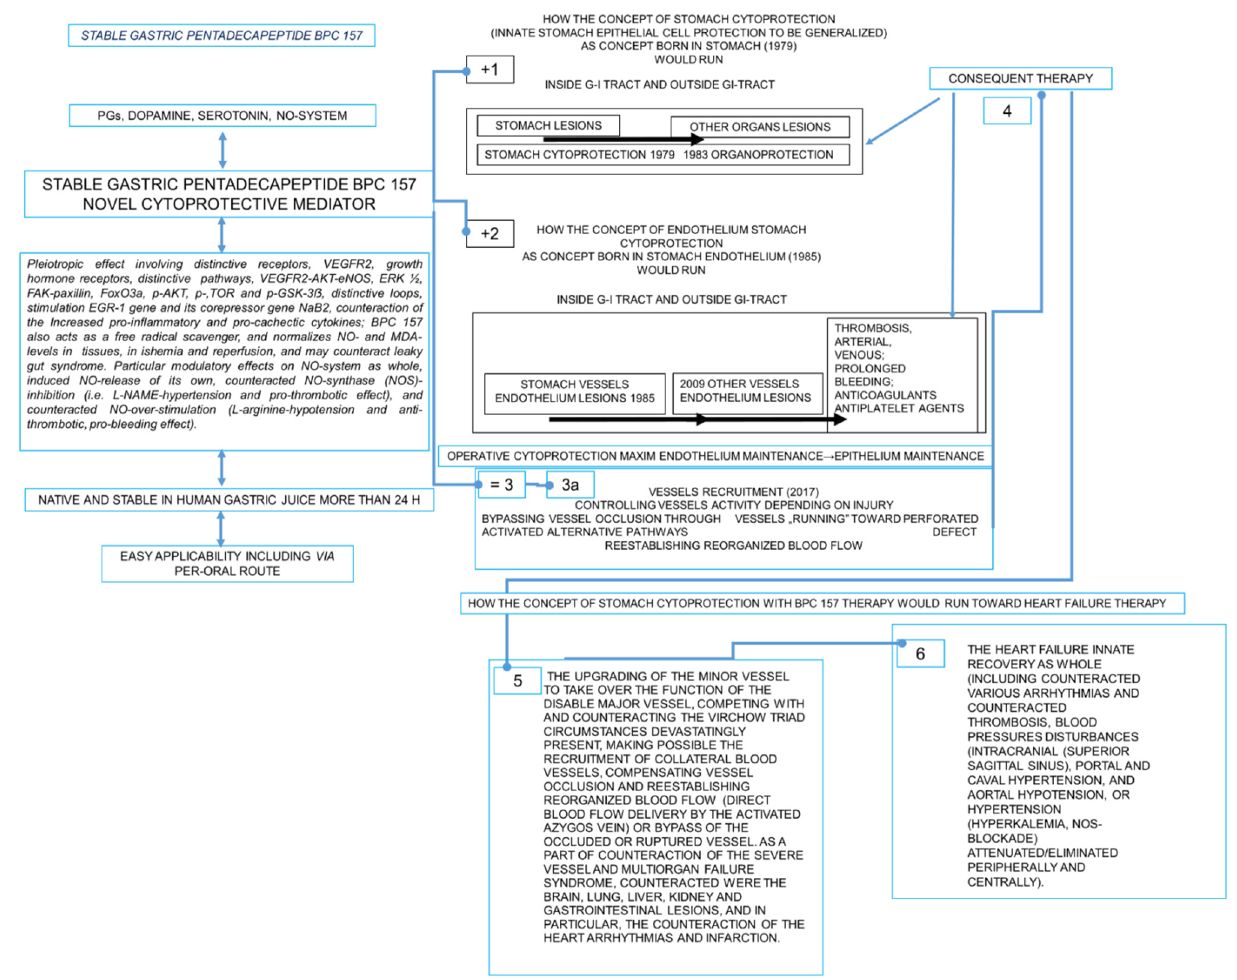
Figure 1. Description of the BPC 157 therapy. Cytoprotection concept (for review, see [2–8,10–17]) born in the stomach appears with cytoprotective agents application as innate stomach epithelial cell protection (indicated as +1) to be generalized (Robert, Szabo) in other organs epithelia protection (organoprotection) supplemented by stomach endothelium cell protection (indicated as +2) (Szabo). Together (+1, +2), these result in cytoprotection stomach maxim endothelial maintenance → epithelial maintenance (indicated as = 3) as axis for the rapid defensive response to resolve the ongoing lesions, which is, however, not fully operative with the standard cytoprotective agents. As novel cytoprotection mediator, BPC 157 might exert prominent epithelial beneficial effects in the stomach and in the whole gastrointestinal tract and in the other organs (stomach cytoprotection → organoprotection) (+1) and endothelial beneficial effect in the stomach (+2). Therefore, BPC 157 therapy might make the stomach maxim endothelial maintenance → epithelial maintenance (indicated as =3) a fully operative axis (indicated as 3a). Further, BPC 157 therapy might extend the original cytoprotection maxim endothelial maintenance → epithelial maintenance from the stomach to the other vessels endothelium protection (3a) [18,19,24,27,29,31,37–41]. In this, BPC 157 might induce particular vessel recruitment and activation depending on injury, i.e., when confronted with vessel occlusion, there was collateral activation to bypass vessel occlusion, as well as when confronted with perforated defect, vessel “running“ toward the defect (3a) [18,19,24,27,29,31,37–41]. The rapid result is the re-establishing of the reorganized blood flow (3a). As consequence, there was a particular therapy that might beneficially affect thrombosis, arterial and venous, and lesions presentation (indicated as 4). For the BPC 157 therapy of the heart failure, BPC 157 therapy might induce particular upgrading of the minor vessel to take over function of the disabled major vessel, resolving Virchow triad circumstances devastatingly present, making possible collateral vessels activation, compensating function of the major vessel, reestablishing reorganized blood flow (direct blood flow by the activated azygos vein) (indicated as 5) [18,19,24,27,29,31,37–41]. In confrontation with the severe syndrome (i.e., heart failure, in